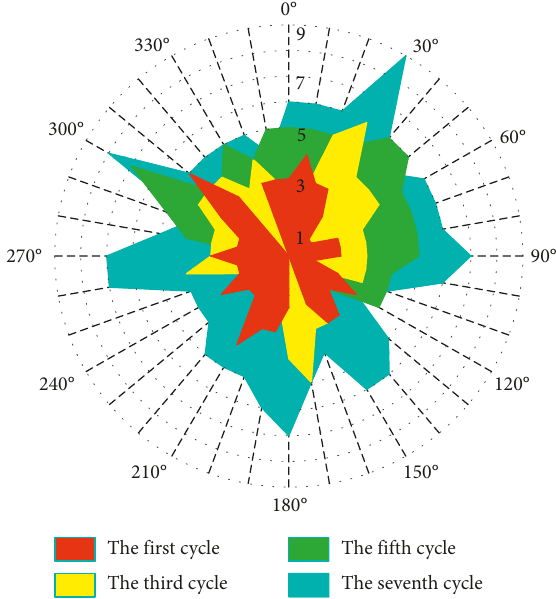
Figure 11: Rose diagram of crack development.